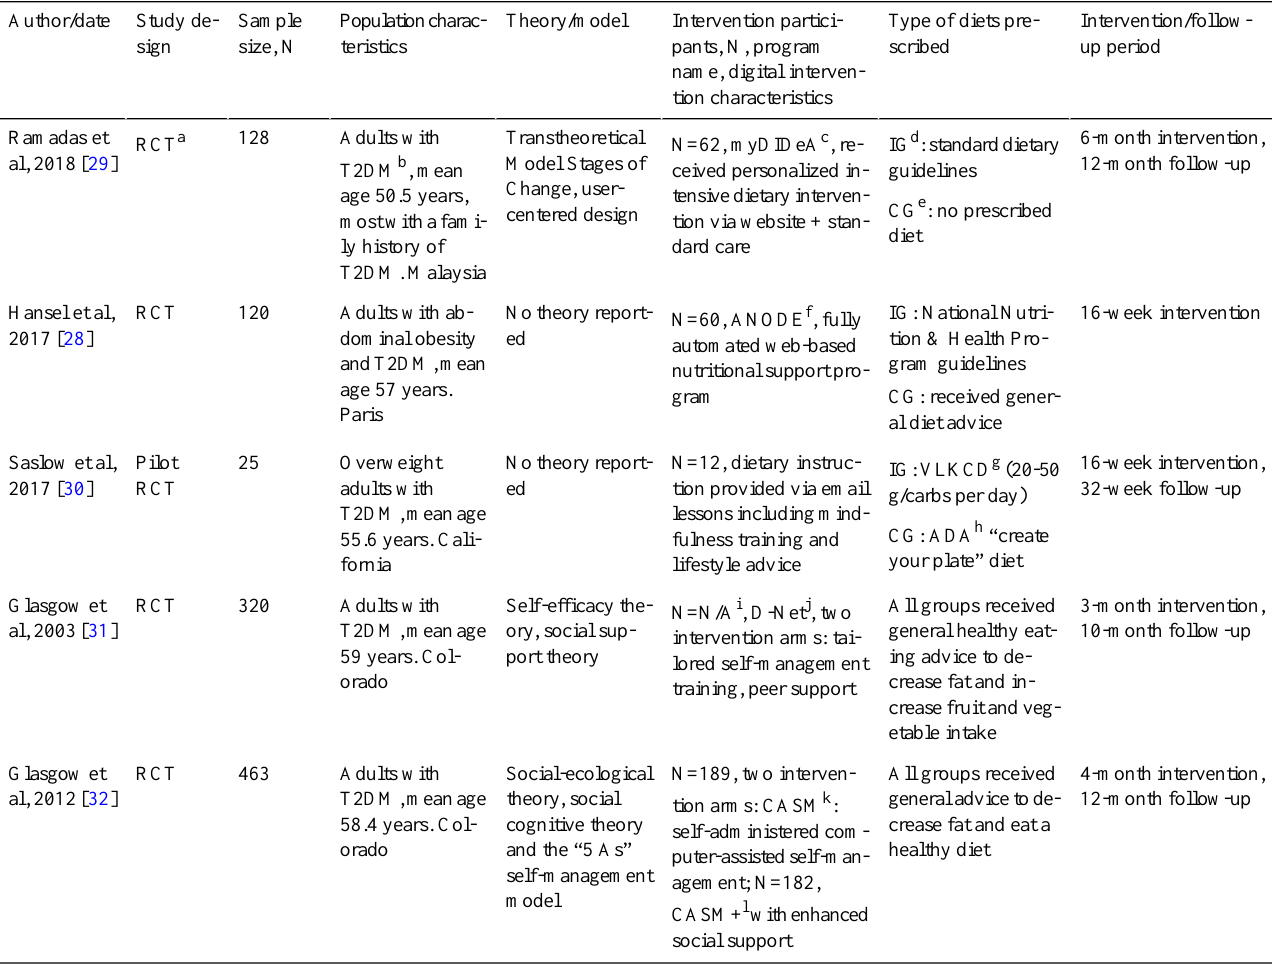
Table 1. Summary of study characteristics for included randomized controlled trials.